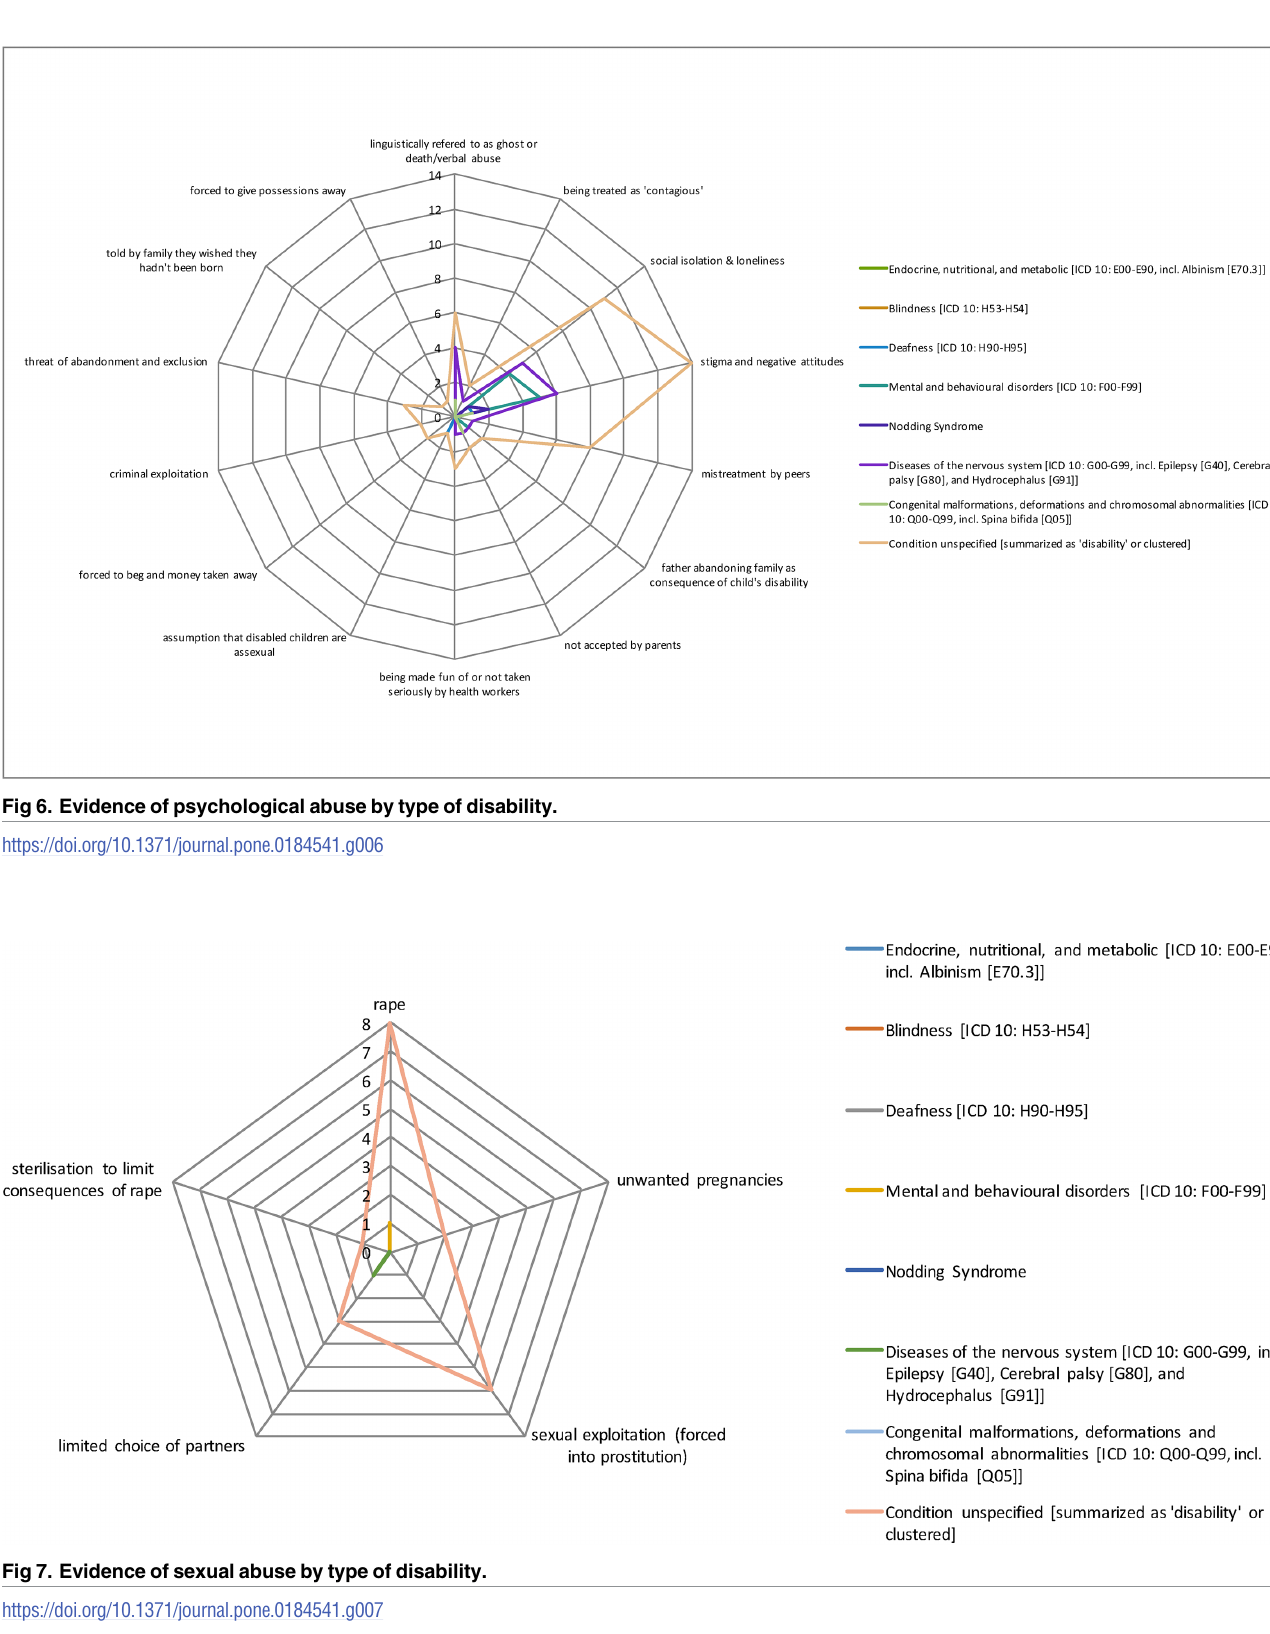
PLOS ONE | https://doi.org/10.1371/journal.pone.0184541 September 11, 2017 10 /